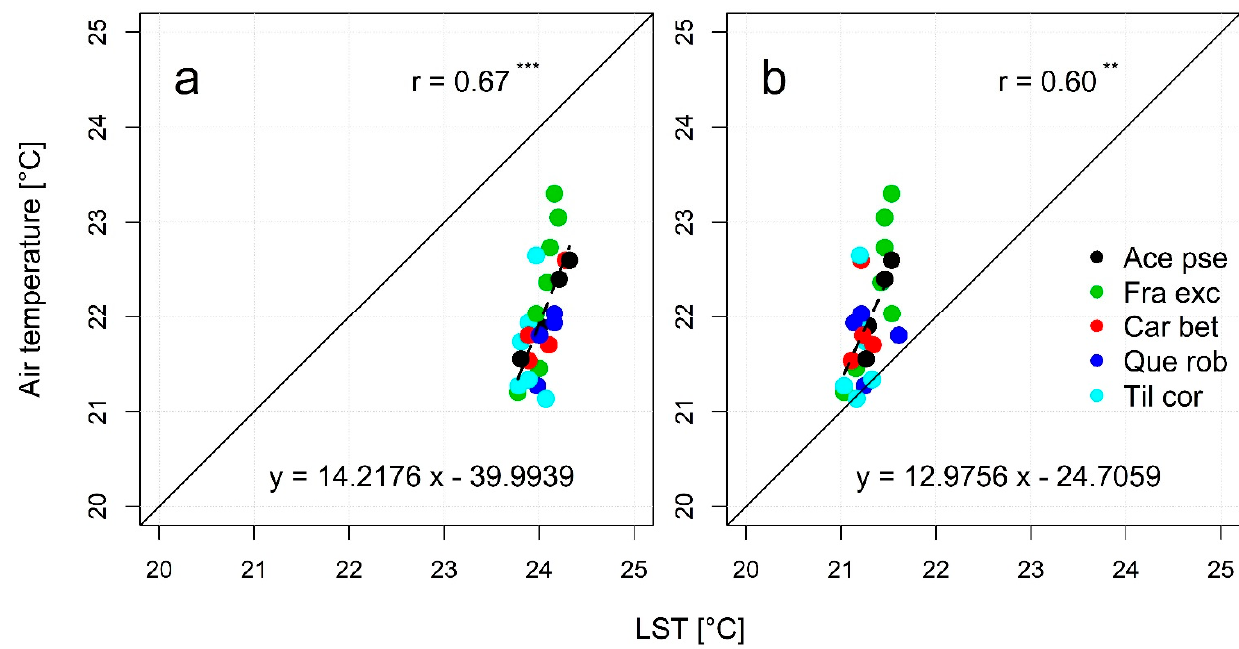
Figure 10. Relationship between tree crown air temperature and ( a ) gyrocopter LST at 30 m resolution, and ( b ) the downscaled Landsat 8 product ( n = 25); asterisk indicates the significance of the correlation (n.s. p > 0.05, * p < 0.05, ** p < 0.01, *** p < 0.001).